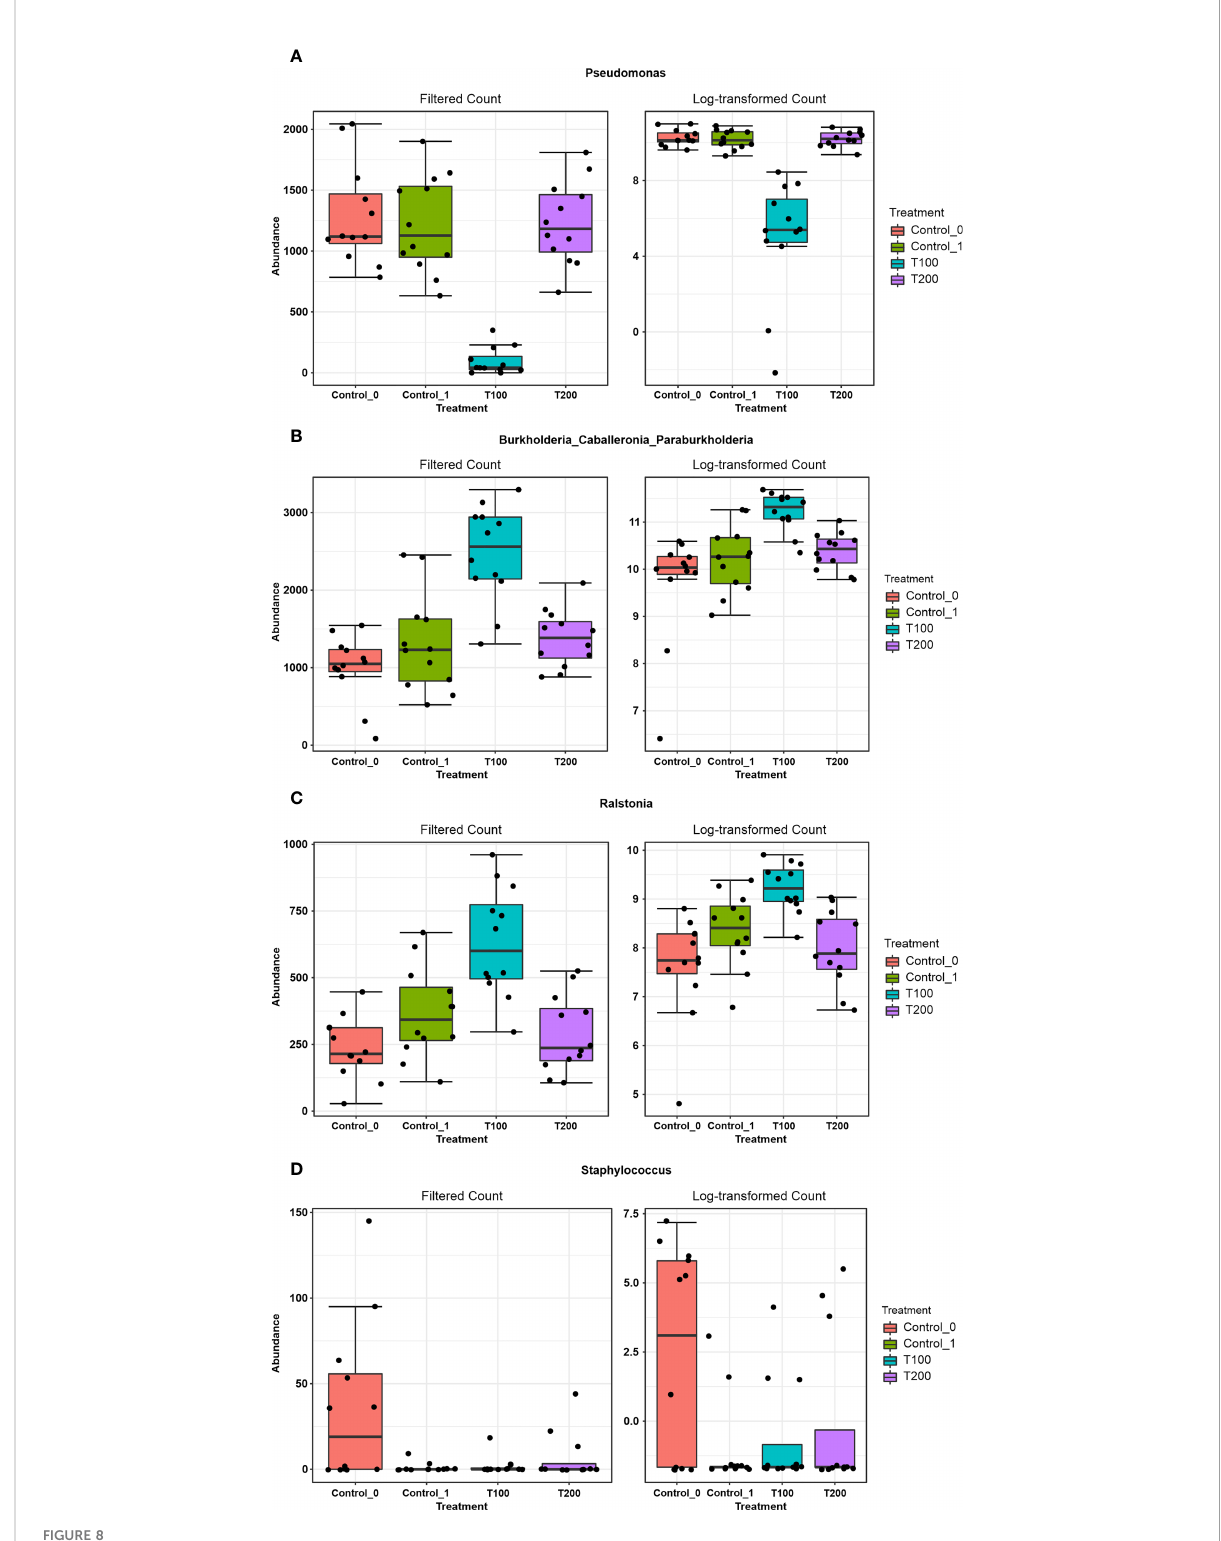
FIGURE 8 The outcome from Microbiome Analyst distinctive features among treatments. Boxplots represent the abundance ( fi ltered and log-transformed count) of the taxa Pseudomonas (A) , Burkholderia-Caballeronia-Paraburkholderia (B) , Ralstonia (C) and Staphylococcus (D) in the four experimental